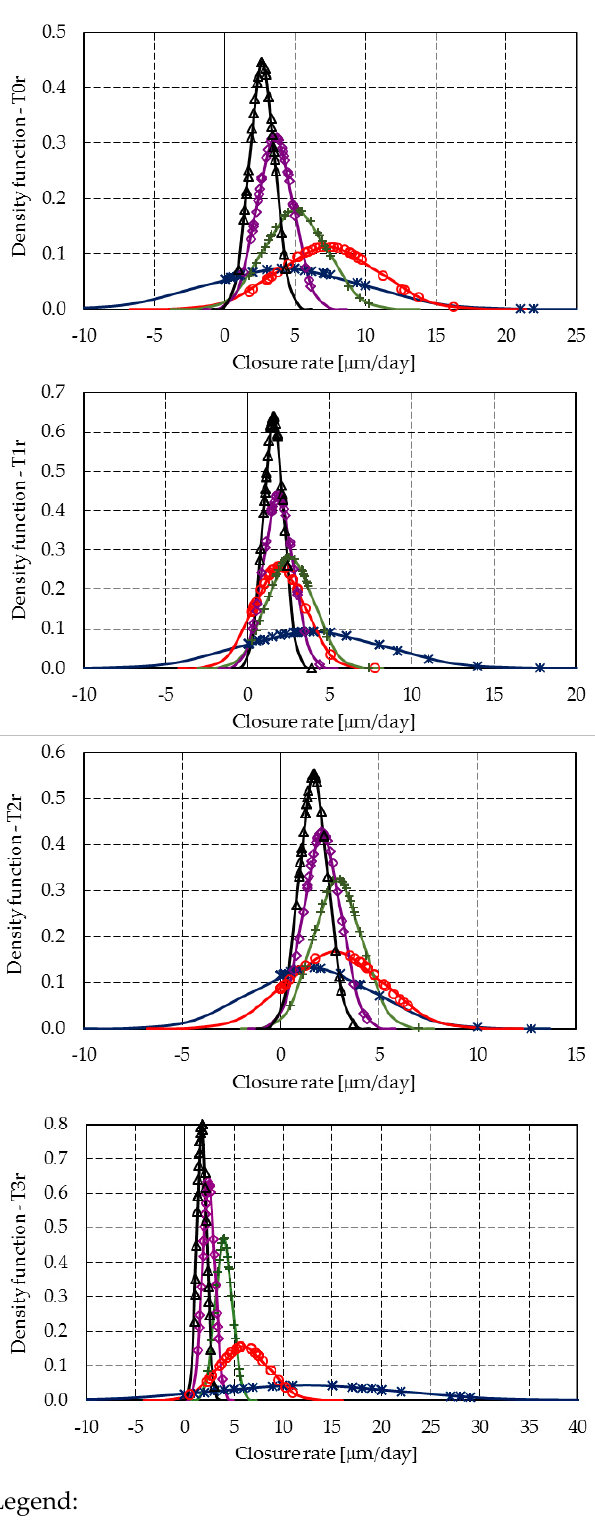
Figure 12. Segmented closure rates — markers correspond to the readings of each crack segment: ( a ) T0r – T3r; ( b ) T0c – T3c.